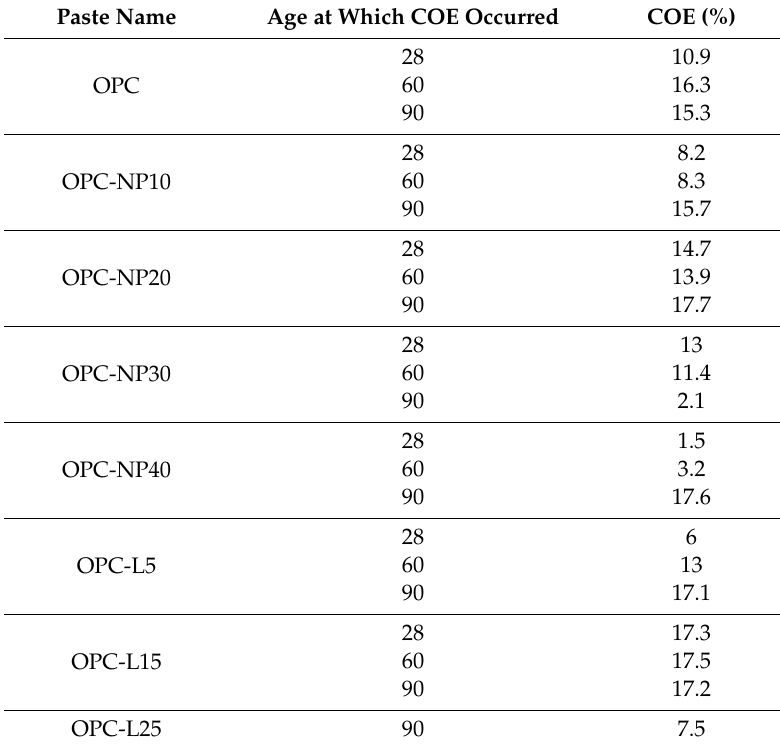
Table 4. COE records with 20–60 ◦ C increase in water curing temperature at ages up to 90 days for OPC, natural pozzolan and limestone powder blended cement